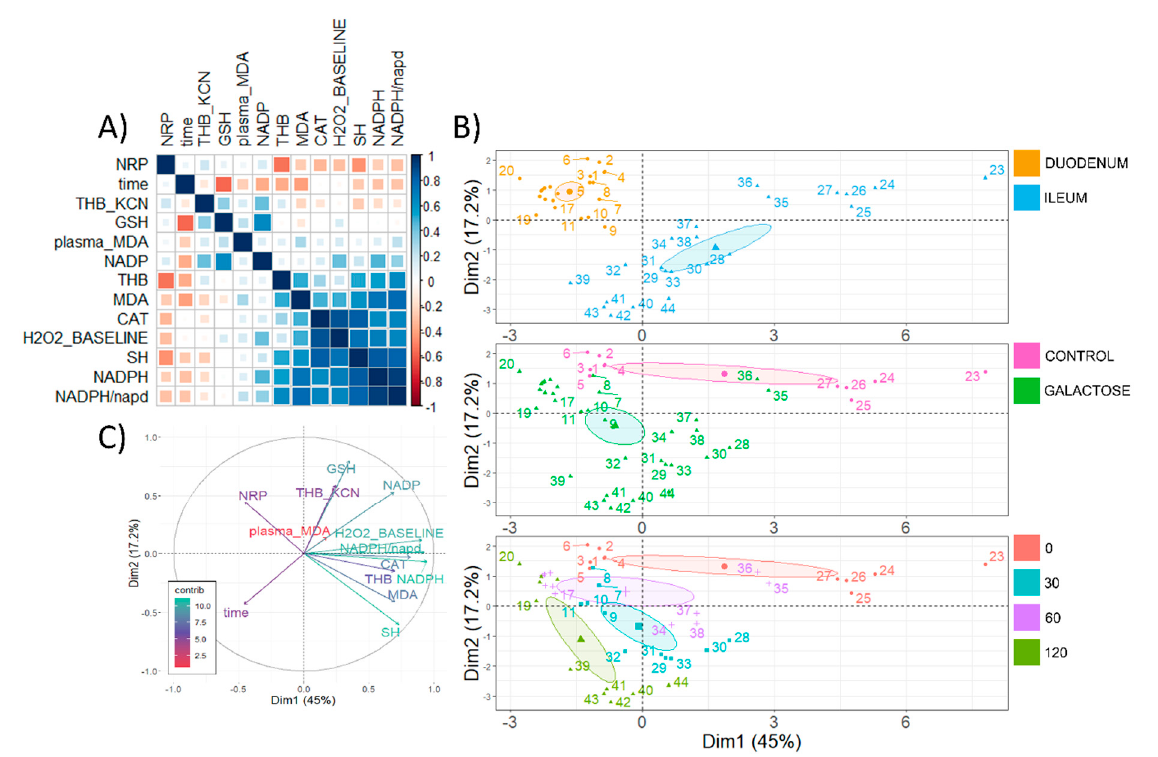
Figure 6. Rank correlation and principal component analysis of rat redox-related parameters in the small intestine following acute orogastric gavage of 200 mg/kg D -galactose. ( A ) Spearman’s rank correlation of redox-related parameters measured in the small intestine (duodenum and ileum) ordered by the first principal component. ( B ) Principal component analysis biplot indicating coordinates of individual animals in respect to 1st and 2nd principal components with colors indicating anatomical segment (upper: duodenum vs. ileum), treatment (center: baseline control vs. galactose treatment), and time since the exposure to orogastric gavage of 200 mg/kg D -galactose solution (lower: baseline control [0] vs. 30 [30] vs. 60 [60] vs. 120 [120] minutes since the exposure). ( C ) A biplot graph of variables’ contributions to the 1st principal component (color and vector projection length) and the 2nd principal component (vector projection length). NRP—nitrocellulose redox permanganom- etry; time—minutes since the exposure to treatment (continuous variable); THB_KCN—change in 1,2,3-trihydroxybenzene autooxidation rate in the presence of 2 mM potassium cyanide (KCN); GSH—glutathione (the main representative of the low-molecular-weight thiols (LMWT)); MDA— malondialdehyde (the main representative of the thiobarbituric acid reactive substances (TBARS)); NADP—nicotinamide adenine dinucleotide phosphate; THB—change in 1,2,3-trihydroxybenzene auto-oxidation rate; CAT—catalase activity (hydrogen peroxide dissociation rate); H 2 O 2 _BASELINE— estimated baseline levels of tissue hydrogen peroxide; SH—protein reactive sulfhydryl groups; NADPH—reduced nicotinamide adenine dinucleotide phosphate; NADPH/nadp—the concentra- tion of reduced nicotinamide adenine dinucleotide phosphate corrected for the concentration of nicotinamide adenine dinucleotide phosphate; contrib—contribution of variables; Dim1—1st dimen- sion; Dim2—2nd